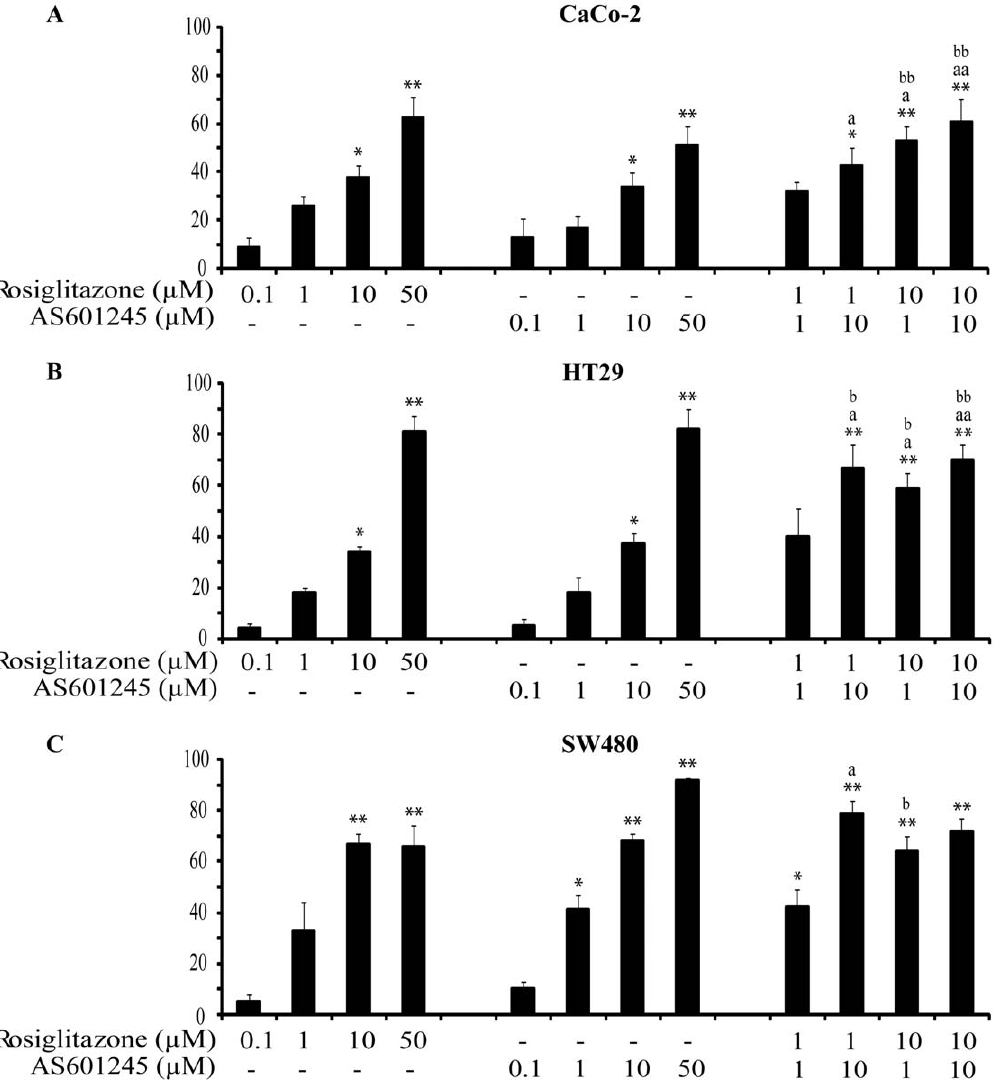
Figure 3. Cell migration. Inhibition of tumour migration by a Boyden chamber assay. CaCo-2, HT29 and SW480 cells were plated onto the apical side of Matrigel-coated filters in serum-free medium supplemented with drugs at different concentrations (0.1, 1, 10, 50 m M rosiglitazone; 0.1, 1, 10, 50 m M AS601245) and with the association of the drugs at different concentrations for 24 hours. Chemoattractant utilized was 20% FCS supplemented medium, placed in the basolateral chamber. The cells migrated to the bottom of the filters were stained using crystalviolet and counted (5 fields of each triplicate filters) using an inverted microscope. Control migration was 45 6 8 cells/microscope fields for CaCo-2 cells, 50 6 5 cells/microscope fields for HT29 and 40 6 3 cells/microscope fields for SW480. Data are expressed as mean 6 SEM (n=5) of the percentage of inhibition versus the migration of cells exposed to vehicle (1% DMSO). Variance analysis * p , 0.05, ** p , 0.01 vs control; a p , 0.05, aa p , 0.01 vs rosiglitazone; b p , 0.05, bb p , 0.01 vs